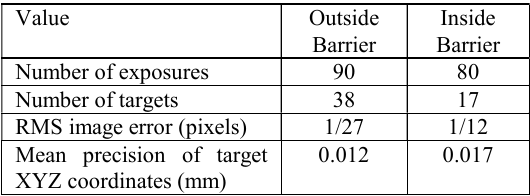
Table 1. Camera calibration results.